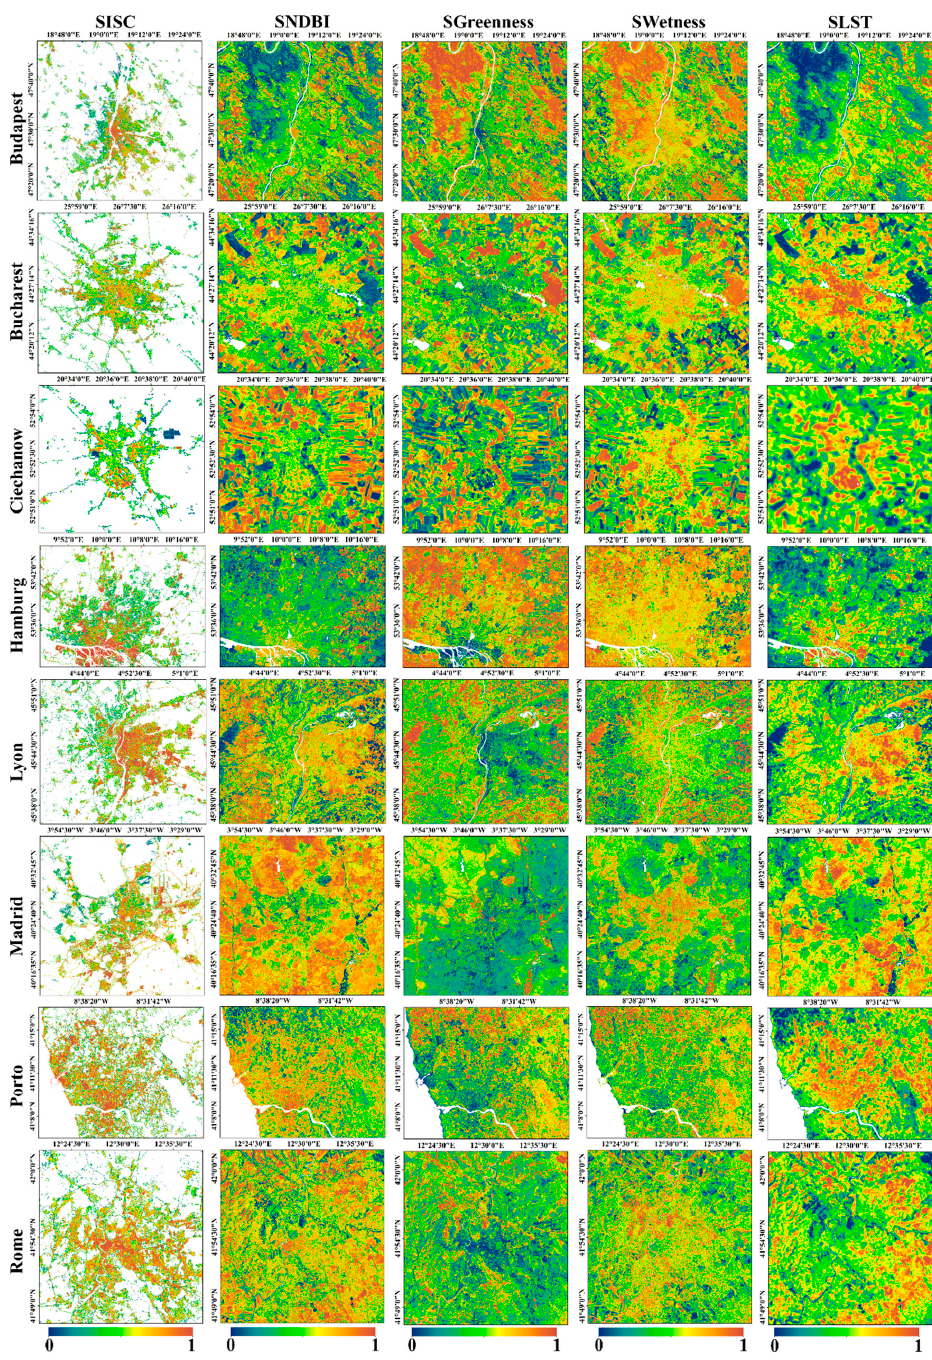
Figure 5. The mean of SISC, SNDBI, SGreeness, SWetness, and SLST maps for selected cities in Europe on different dates.